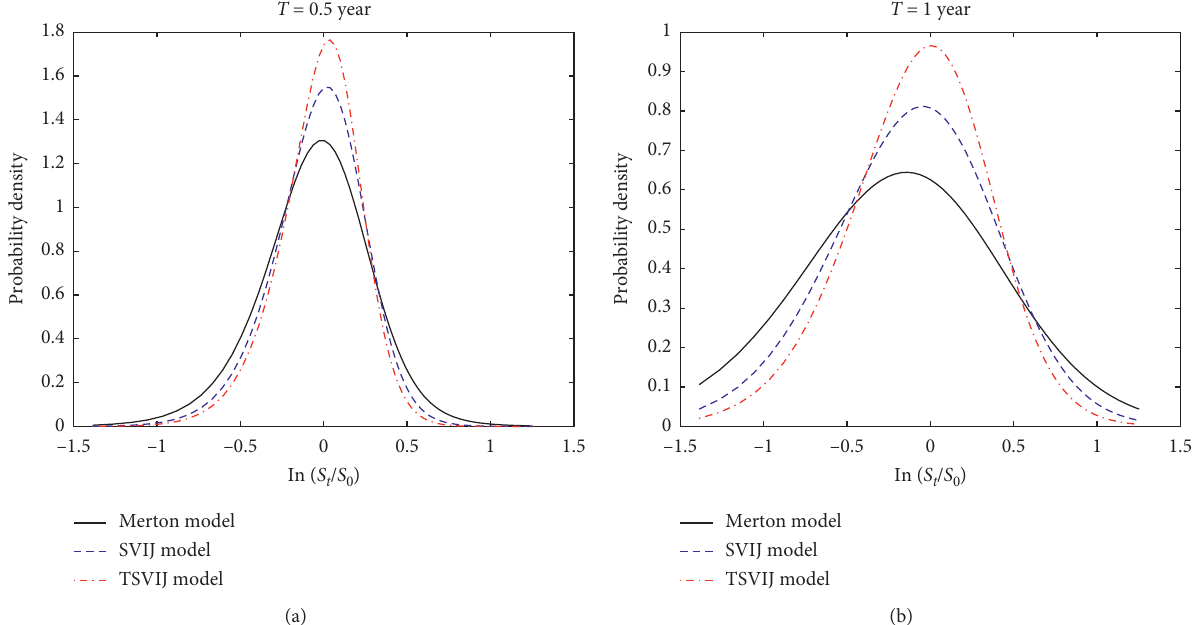
Figure 8: Comparison of probability density function in three different models.